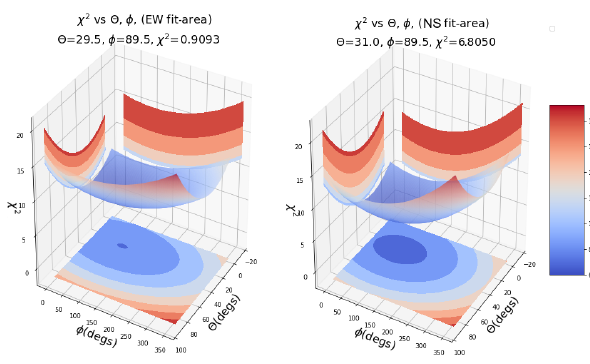
Figure 9. The distribution of ∆ θ between the zenith angle es- timated using the VRM and the corresponding angle estimated using the particle detector data. The distribution is fitted with Gaussian function of sigma equal to 6